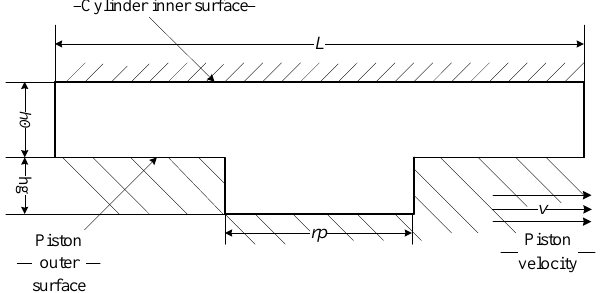
Figure 4. Cross-section model of flow field for control unit with cylindrical texture.